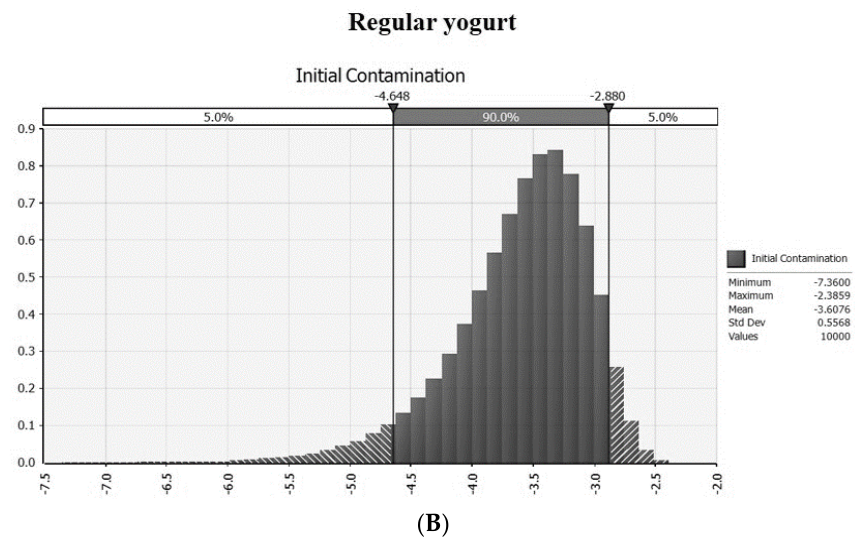
Figure 1. The probability distribution of initial contamination level of Listeria monocytogenes and EHEC in drinking ( A ) and regular yogurt ( B ).